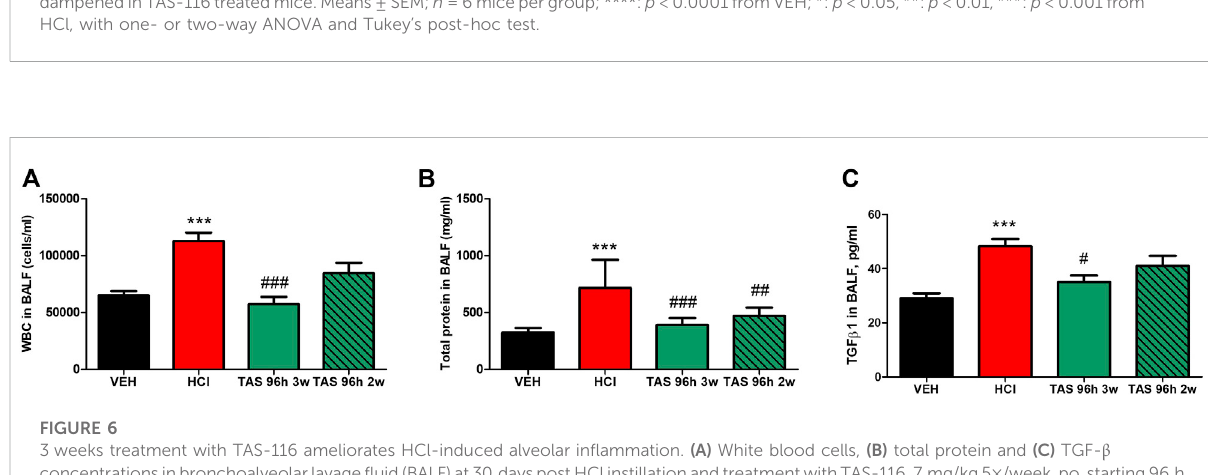
3 weeks treatment with TAS-116 ameliorates HCl-induced alveolar in fl ammation. (A) White blood cells, (B) total protein and (C) TGF- β concentrationsinbronchoalveolarlavage fl uid(BALF)at30 dayspostHClinstillationandtreatmentwithTAS-116,7 mg/kg5×/week,po,starting96